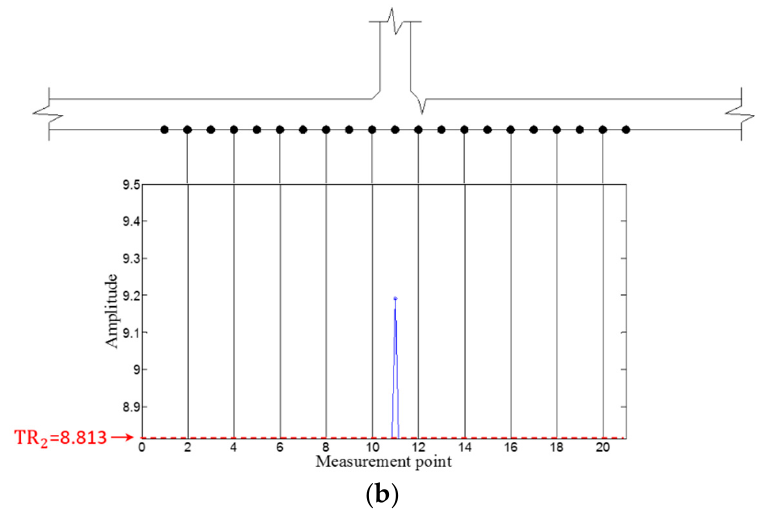
Figure 19. ZLCC values obtained from the crack area at 150 kHz ( a ) before and ( b ) after applying TR 2 .